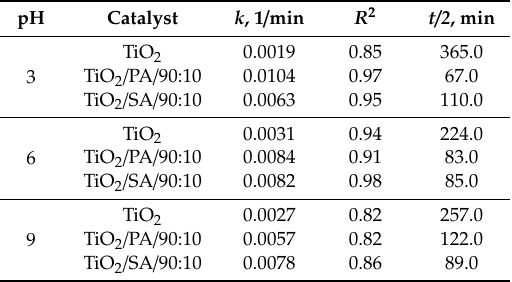
Table 5. E ff ect of pH on the kinetics of the